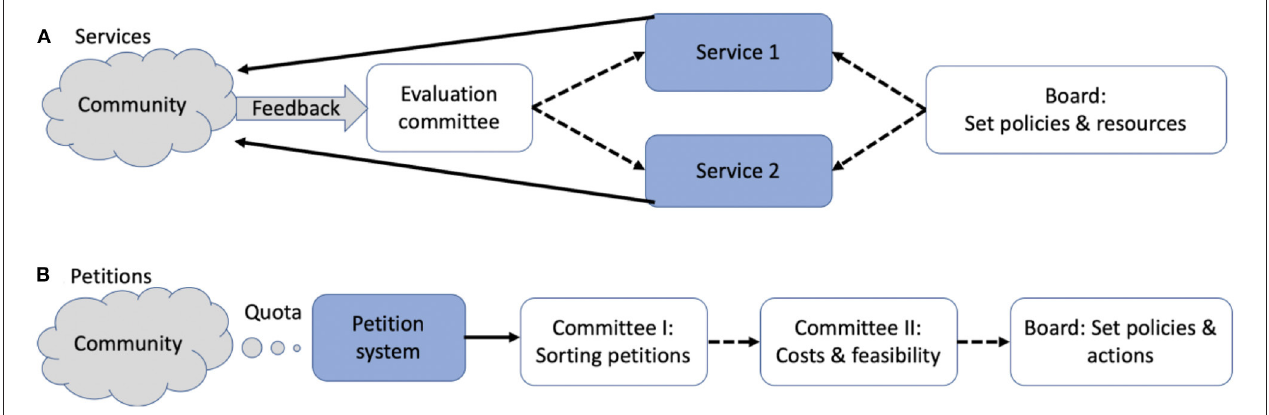
FIGURE 1 | Governance structure for (A) NGO providing two types of online services to a community, (B) community governance via a petition system guiding policies and actions. Solid arrows represent primary processes and dotted arrows secondary (slower)